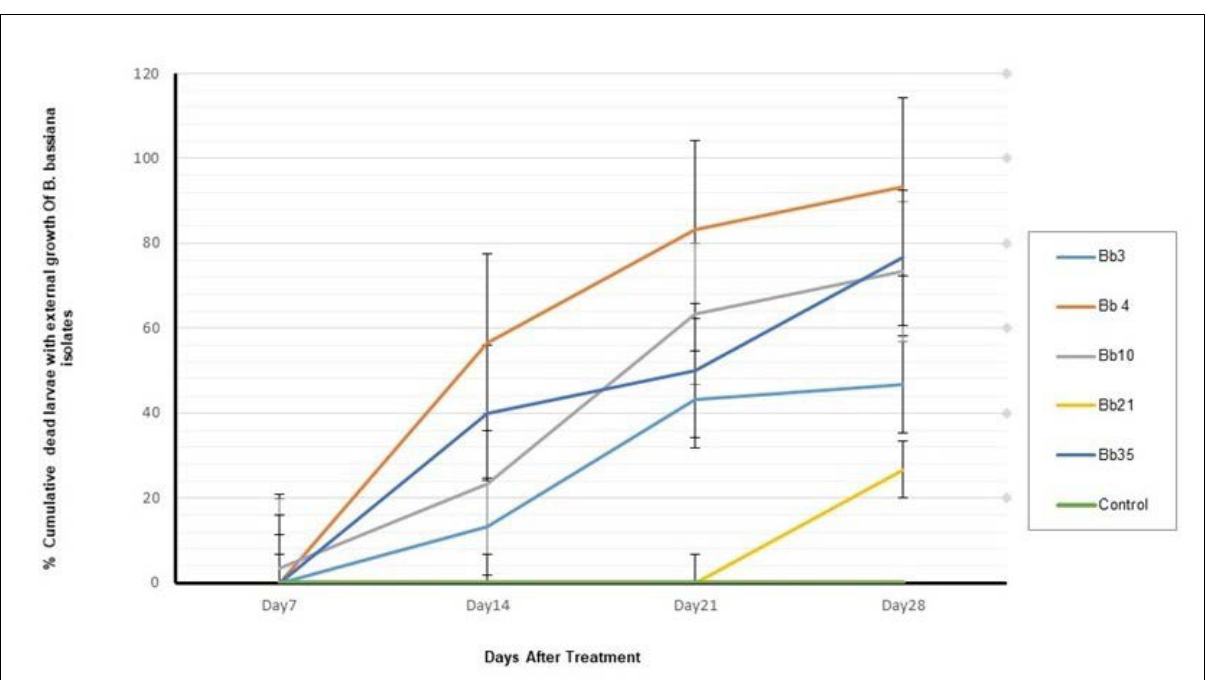
Figure 3: Cumulative mortality (%) of third instar larvae of Sesamia calamistis caused by five endophytic Beauveria bassiana